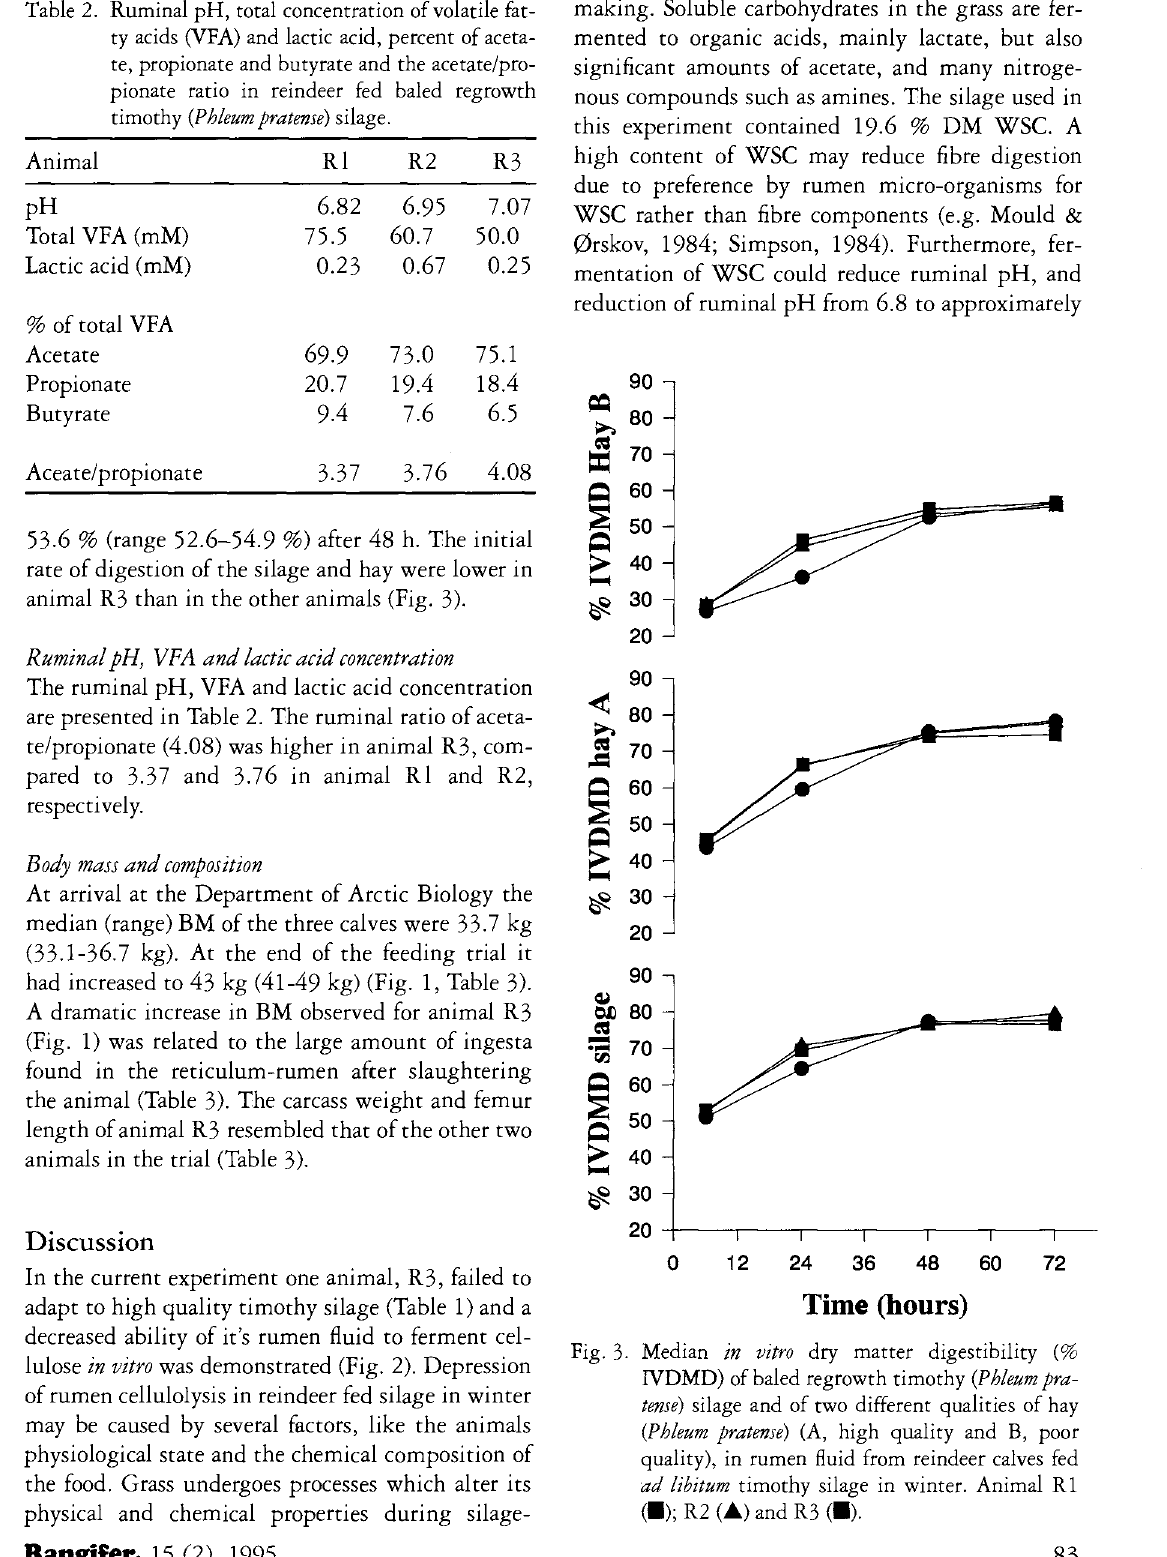
Table 2. Ruminal pH, total concentration of volatile fat ty acids (VFA) and lactic acid, percent of aceta